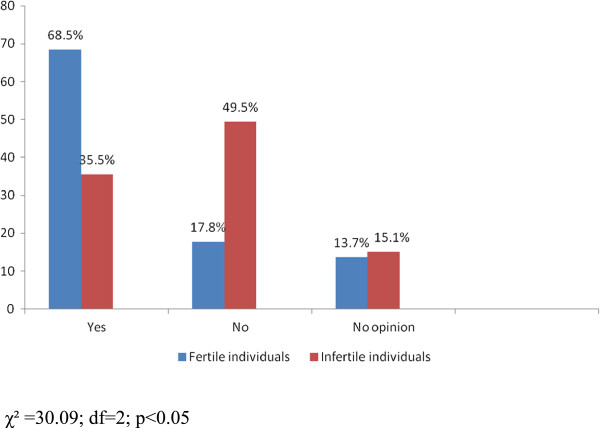
Is the embryo a human being?